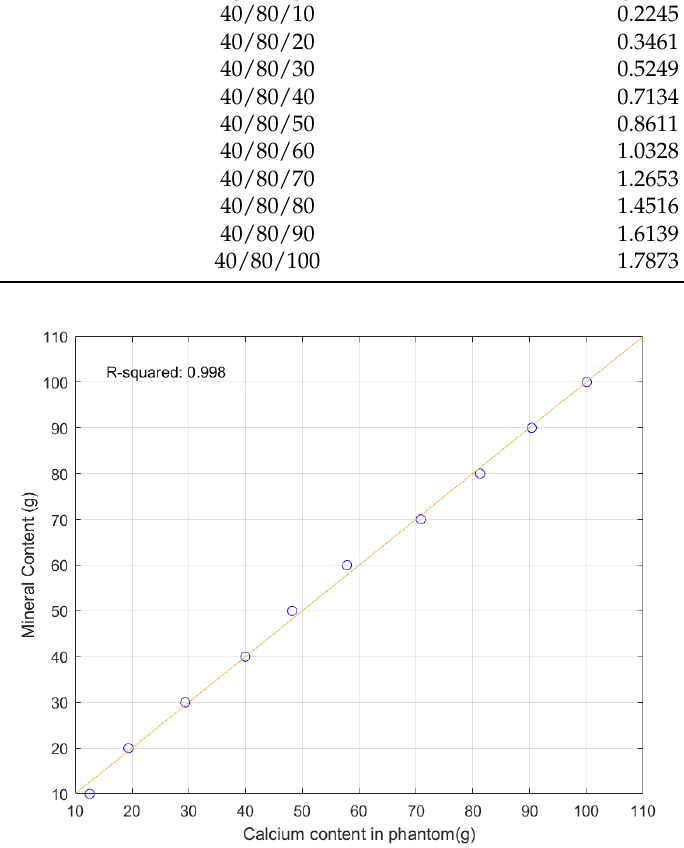
Figure 12. Plot of real calicium content (x axis) against computed mineral (calcium) content (y axis).